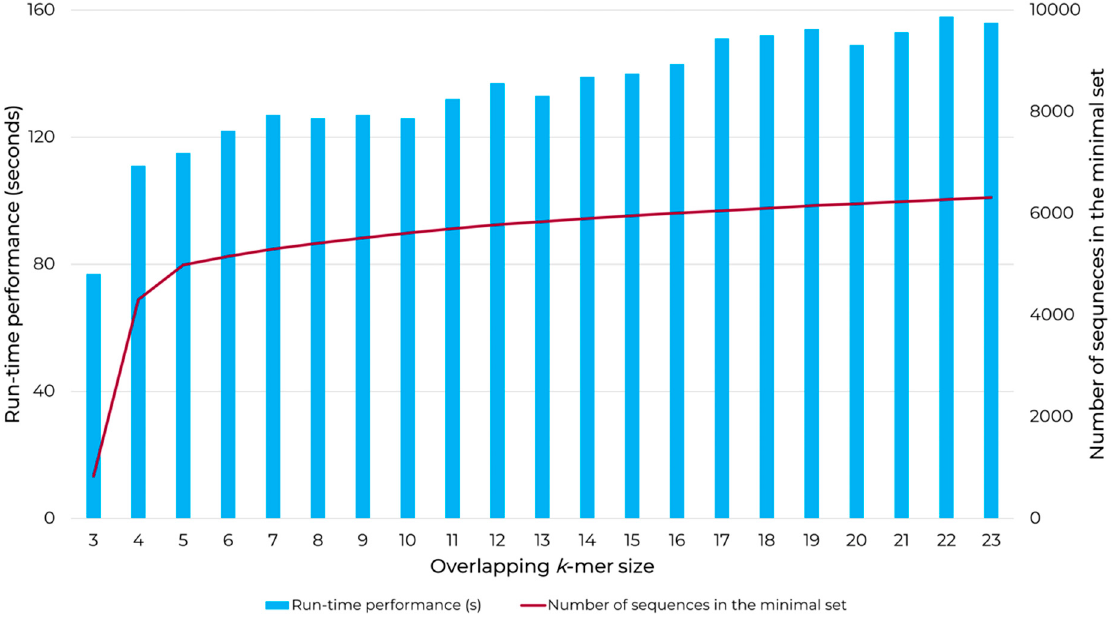
Figure 3. Comparison of the number of sequences in the minimal set and the run-time performance for different overlapping k -mer sizes.